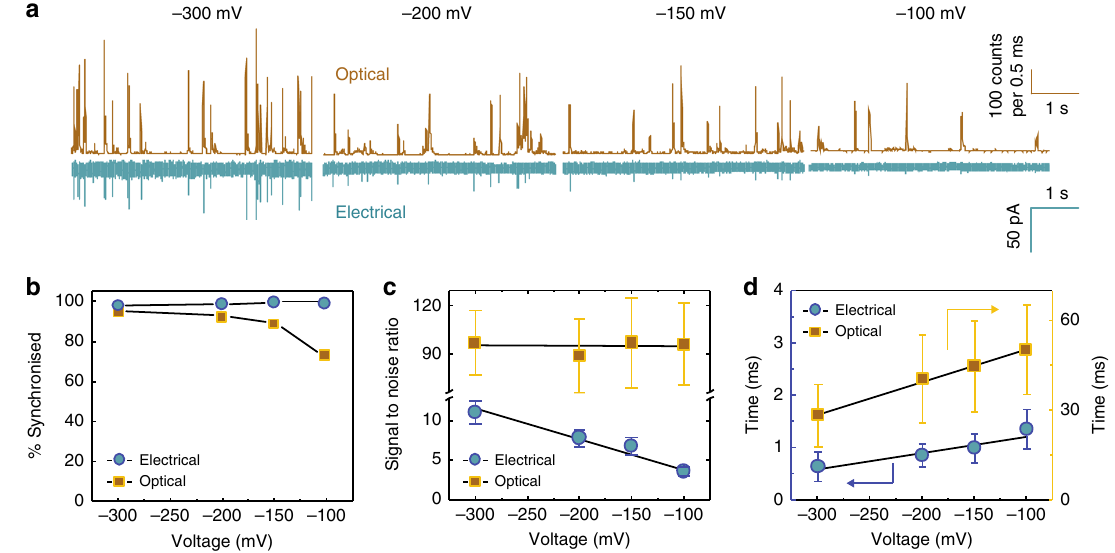
Fig. 2 Single-molecule electro-optical detection of 5 kbp DNA labelled with YOYO-1. a Photon and current time traces for the translocation of 100 pM 5 kbp DNA-YOYO-1 in 100 mM KCl, 10 mM Tris-HCl, 1 mM ethylenediaminetetraacetic acid (EDTA) buffer (pH = 8). The resampling time for the photon time trace is 500 μ s and the fi lter cut-off frequency for the current time trace is 10 kHz. Laser power was 90 ± 3 μ W. b Percent synchronisation, c signal to noise and d dwell time as a function of applied voltage for the electrical (blue circles) and optical (brown squares) channels respectively. The error bars represent the accumulation of statistics from at least three different